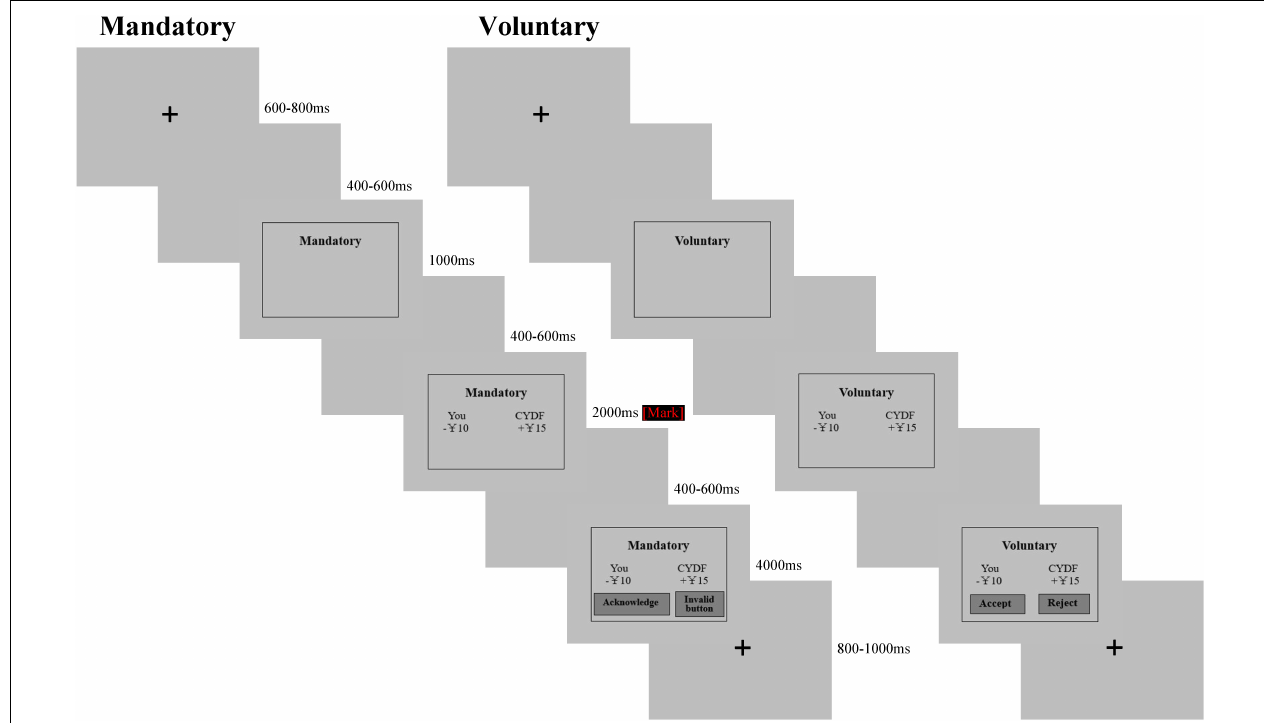
FIGURE 2 | Experimental task: Participants were instructed to make donation decisions in two contexts (mandatory and voluntary). Electroencephalograms (EEGs) were recorded from the subjects throughout the